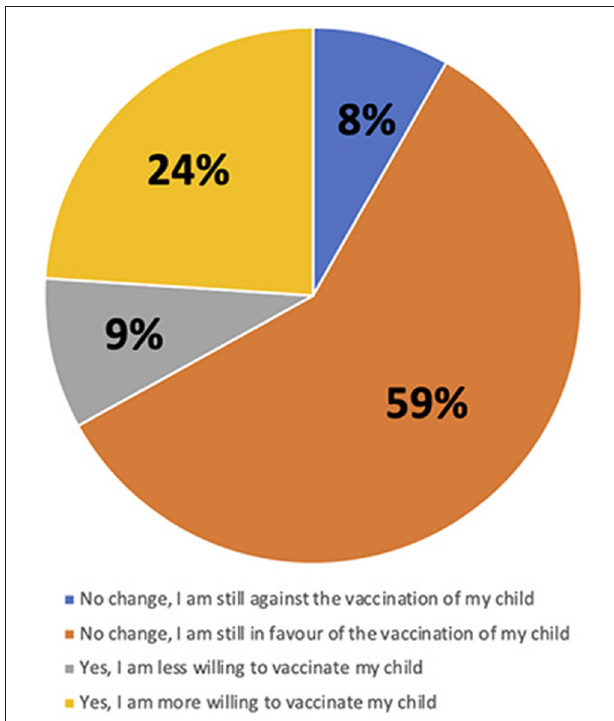
FIGURE 2 | Change of caregivers’ attitudes toward COVID-19 vaccination of his/her child after the child’s COVID-19 infection.